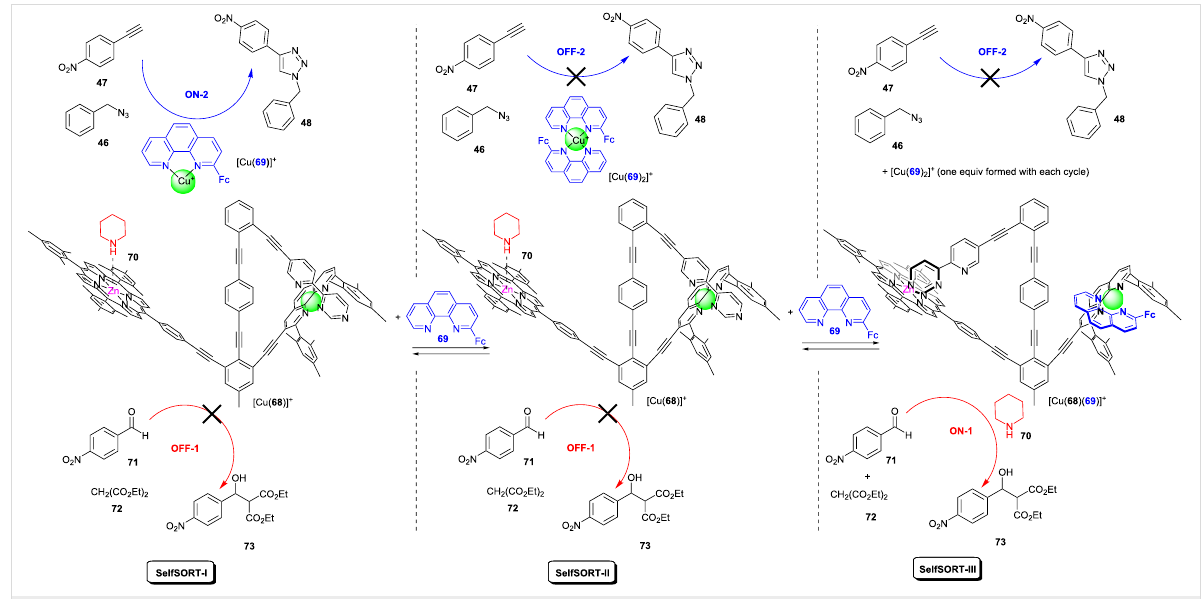
Figure 19: Two catalytic reactions are alternately controlled by a toggle nanoswitch.